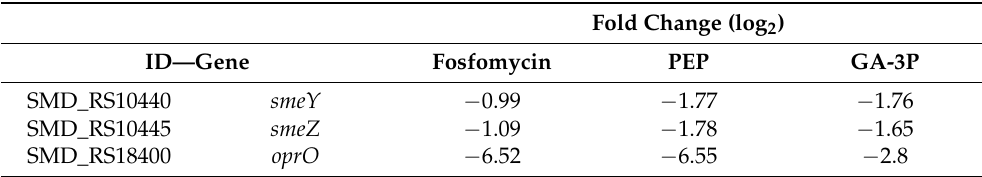
Table 6. Fold change (log 2 ) of efflux pumps and porins presenting different levels of expression after the treatments, in comparison with the wild-type D457 strain without treatment.